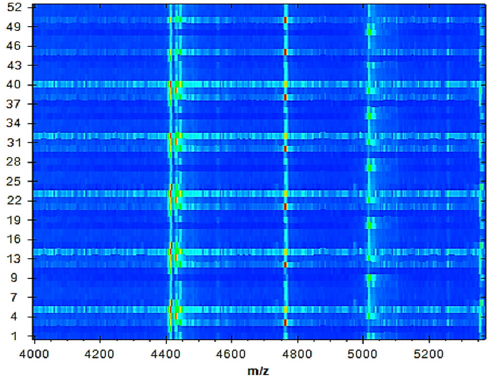
Fig. 4. A gel protein spectrum for 52 E. faecalis strains demonstrates that most peaks are condensed between 4, 400 and 5, 000